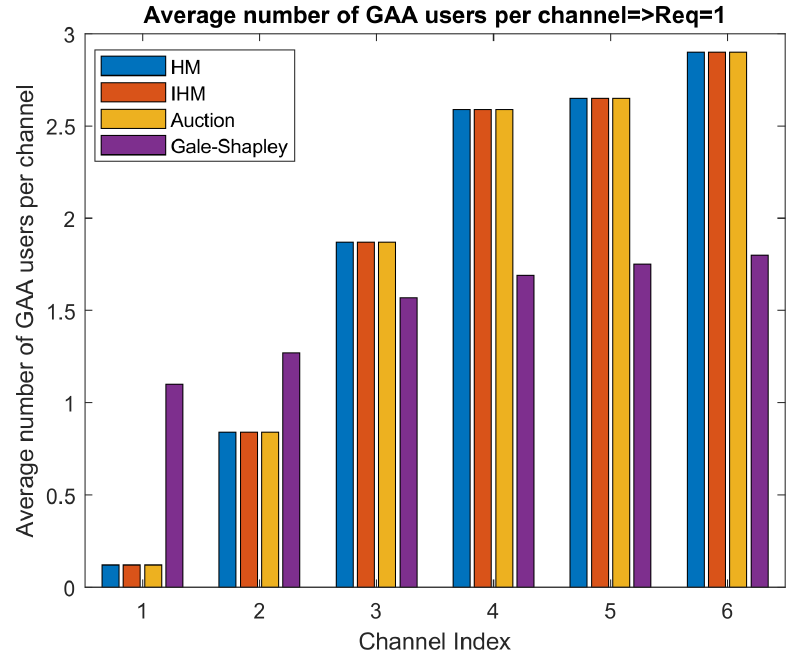
Figure 5. Average number of users when channel required: